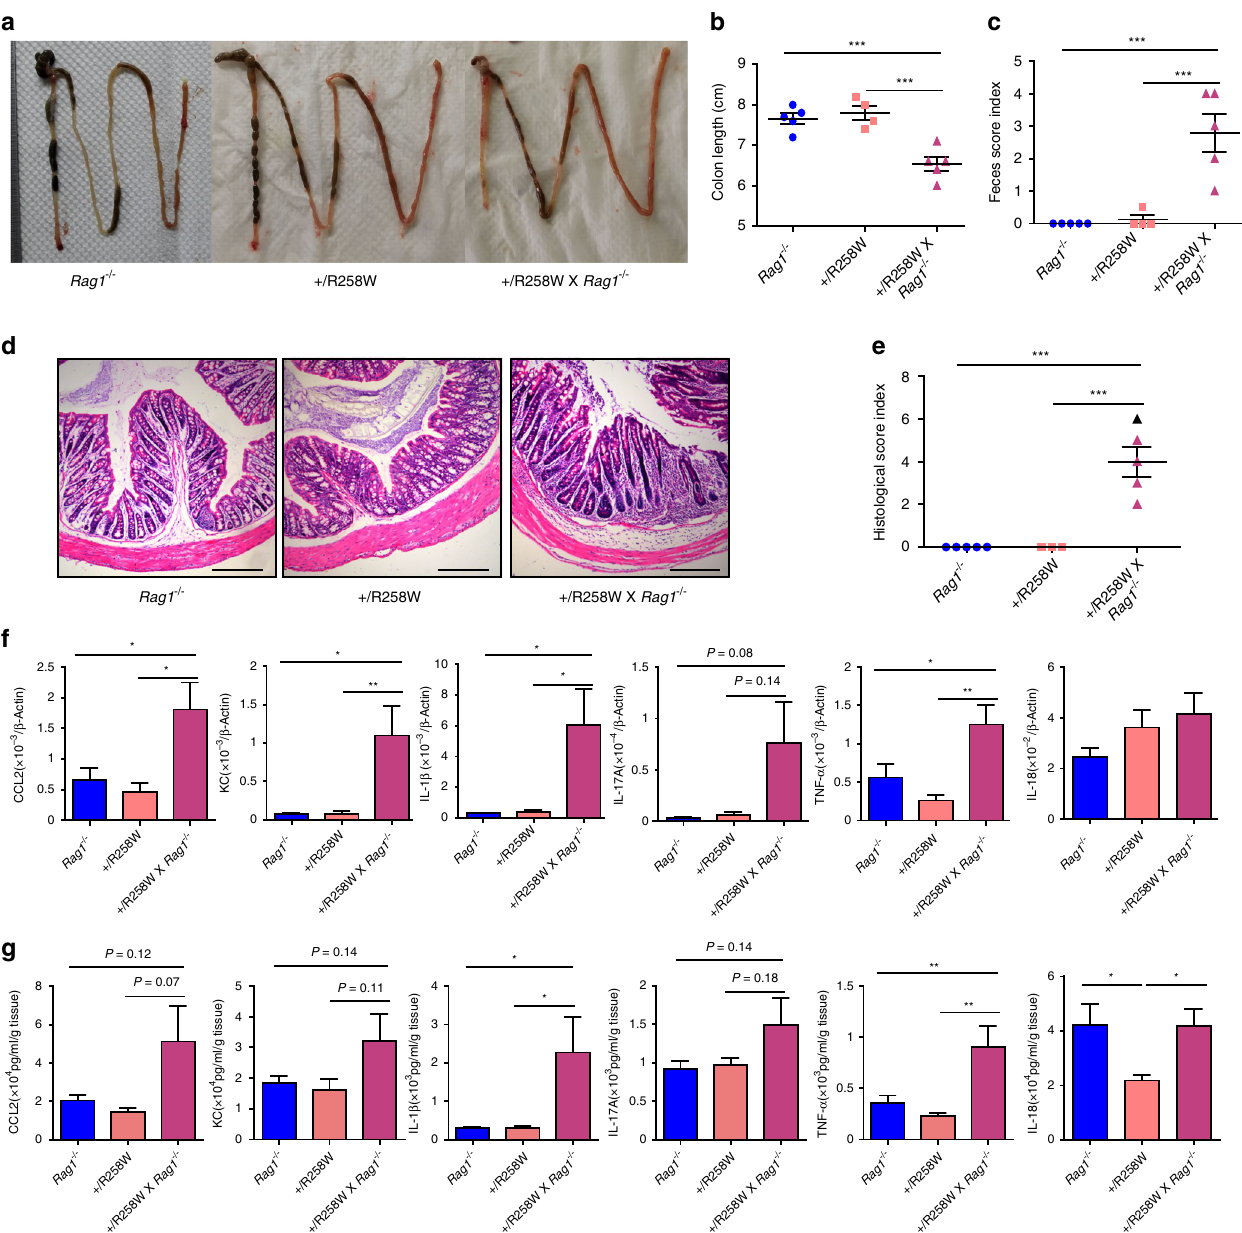
Fig. 8 The Nlrp3 R258W x Rag1 − / − mice develop spontaneous colitis. a – e Characterization of the spontaneous colitis in Nlrp3 R258W x Rag1 − / − mice ( n = 5) together with Rag1 − / − ( n = 5) and Nlrp3 R258W ( n = 4) mice as control, the morphology ( a ), colon length ( b ), feces score ( c ), and histological examination ( d ), scale bar is 200 μ m, and histological score ( e ) of Rag1 − / − , Nlrp3 R258W , and Nlrp3 R258W × Rag1 − / − mice were monitored. f , g The indicated in fl ammatory cytokine/chemokine expression ( f ) and secretion ( g ) from the colon tissue of indicated mice were determined through Q-PCR and ELISA, respectively. Data are shown as the means ± SEM. * P < 0.05, ** P < 0.01, *** P < 0.001 (one-way ANOVA with Dunnett ’ s post-hoc